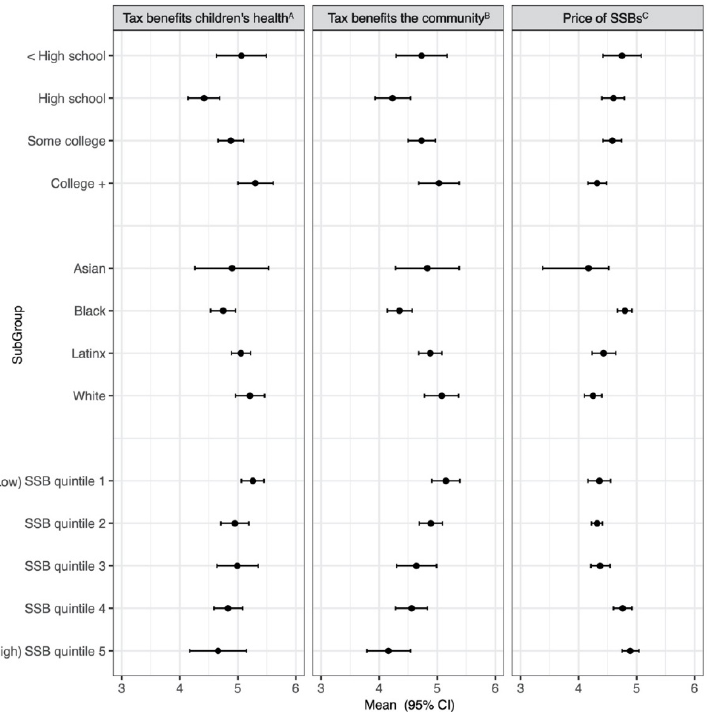
Figure 4. Adjusted mean perceptions about SSB taxes by education, race/ethnicity, and quintiles of SSB consumption, 2017. Adjusted marginal predicted means from mixed-effects models adjust for thinking there is a tax, living in a taxed city, education, quantile of SSB consumption, race/ethnicity, gender, and age, and include random intercept for neighborhood. Results represent adjusted marginal predicted means among full sample of respondents in 2017. A 1 = extremely bad for children’s health, to 7 = extremely good for children’s health, N = 822. B 1 = extremely bad for the community, to 7 = extremely good for the community, N = 819. C 1 = extremely cheap, to 7 = extremely expensive, N = 1166. N =